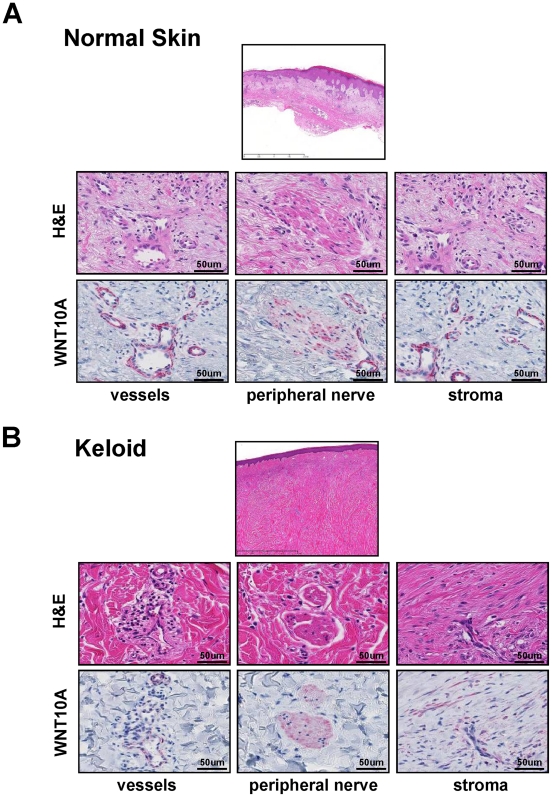
WNT10A is expressed in stromal cells of keloid tissue.H&E and anti-WNT10A antibody staining in (A) normal skin and (B) keloid tissue. WNT10A was expressed around the vessels and in the peripheral nerve cells of normal skin, but not in stromal cells. In contrast, WNT10A was expressed around vessels, in peripheral nerve cells and strongly in stromal cells of keloid tissue. Vulcan fast red was used for WNT10A staining (red color).